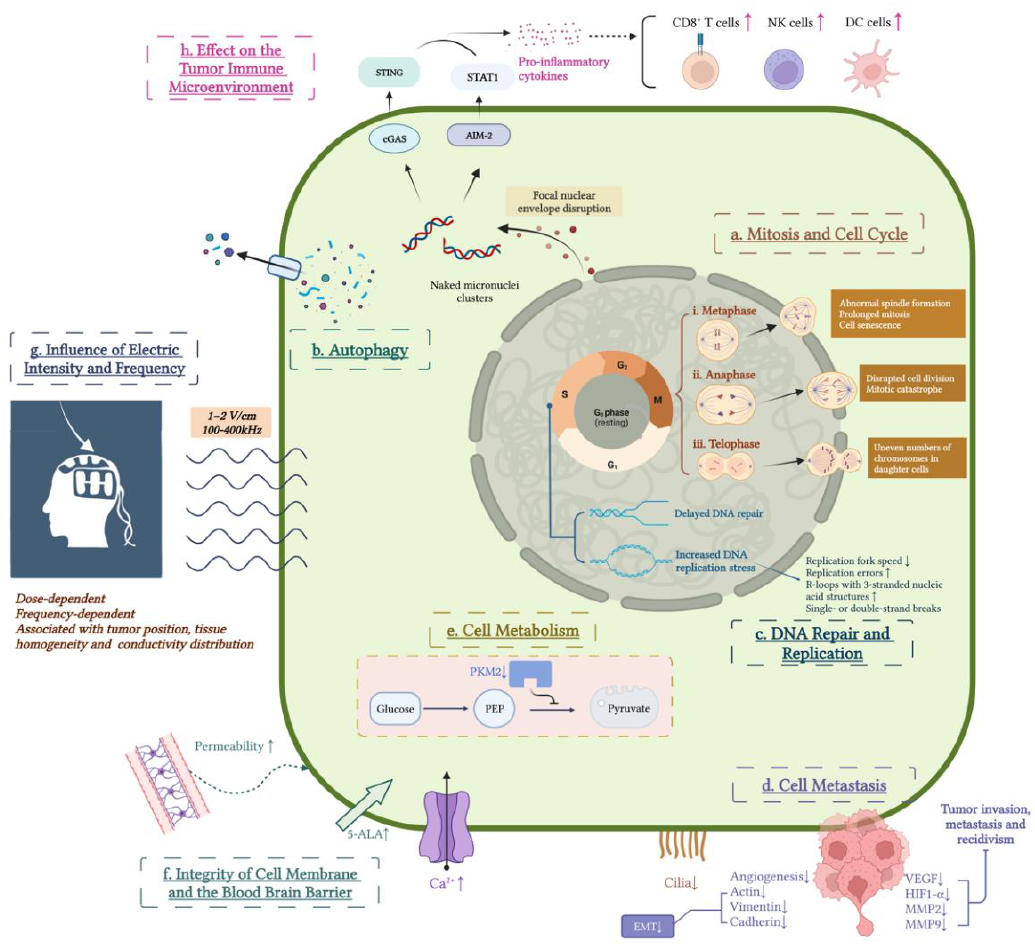
Figure 2. Biological mechanisms of action of TTFields in GBMs. ( a ) TTFields therapy disrupts the cell cycle and mitosis of GBMs in multiple phases, including (i) metaphase, (ii) anaphase, and (iii) telophase. ( b ) TTFields therapy enhances autophagy and leads to subsequent cell death by inducing aneuploidy in daughter cells. ( c ) TTFields therapy delays DNA repair and enhances DNA replication stress. ( d ) Cell metastasis is inhibited by TTFields through prevention of angiogenesis, downregulation of metastasis-related proteins, and suppression of the primary cilia. ( e ) TTFields therapy inhibits the expression of pyruvate kinase M2 and therefore reduces cell metabolism. ( f ) The integrity of the cell membrane and blood–brain barrier (BBB) is disrupted by TTFields, resulting in increased 5-aminolevulinic acid uptake, activated calcium channels on the membrane, and elevated transmission of nonpermeable pharmacological agents through the BBB to the tumors. ( g ) TTFields therapy shows diverse efficacy under different electric intensities and frequencies and is influenced by the conductivity of the skull, tumor position, and tissue homogeneity. ( h ) TTFields therapy changes the immune microenvironment of GBMs from ‘cold’ to ‘hot’ by upregulating proinflam- matory cytokines and activating intratumoral infiltrated immune cells via the cGAS/STING and AIM2/caspase-1